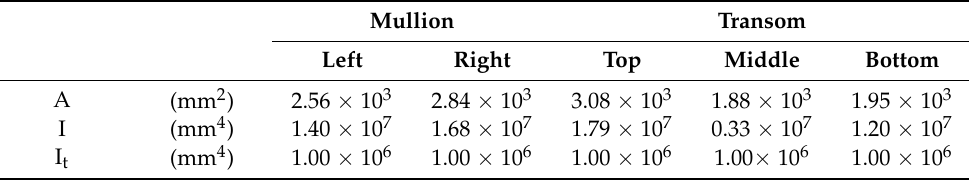
Table 3. Nominal properties of the frame members. Key: A = cross-sectional area, I = second moment of area; I t = torsional moment.